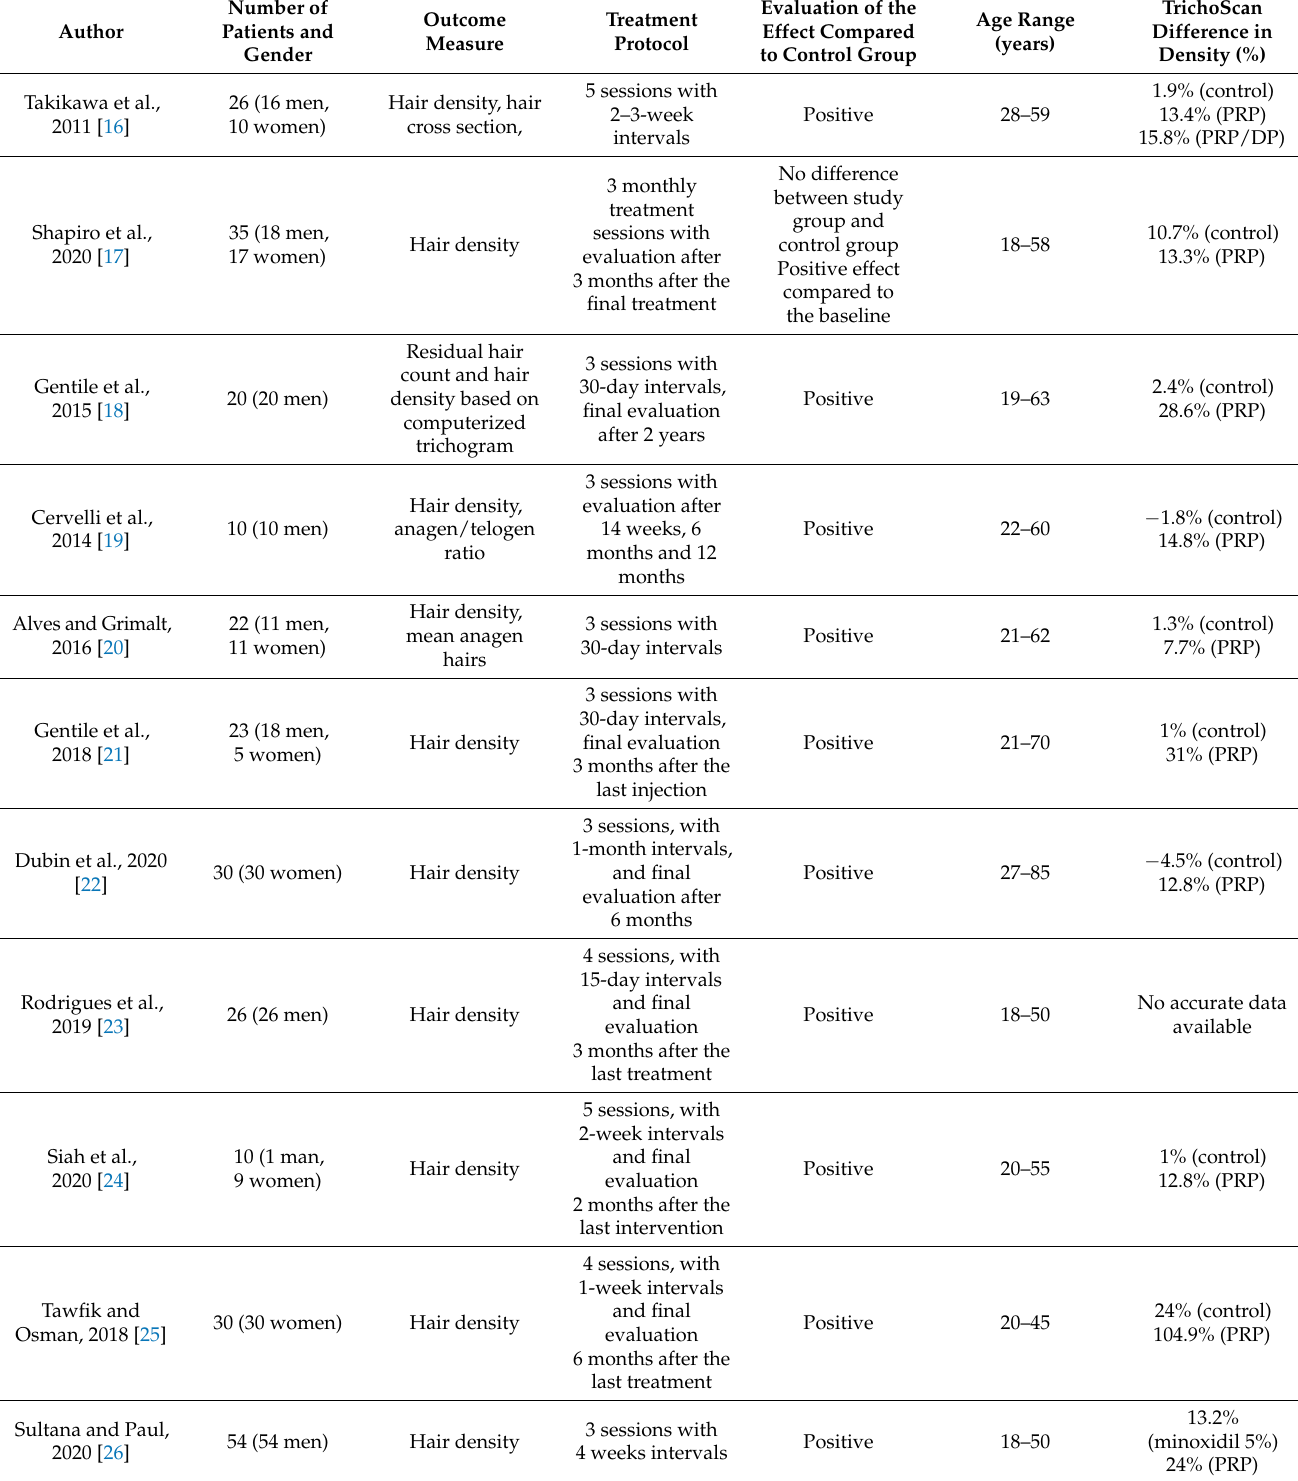
Table 1. Characteristics of the